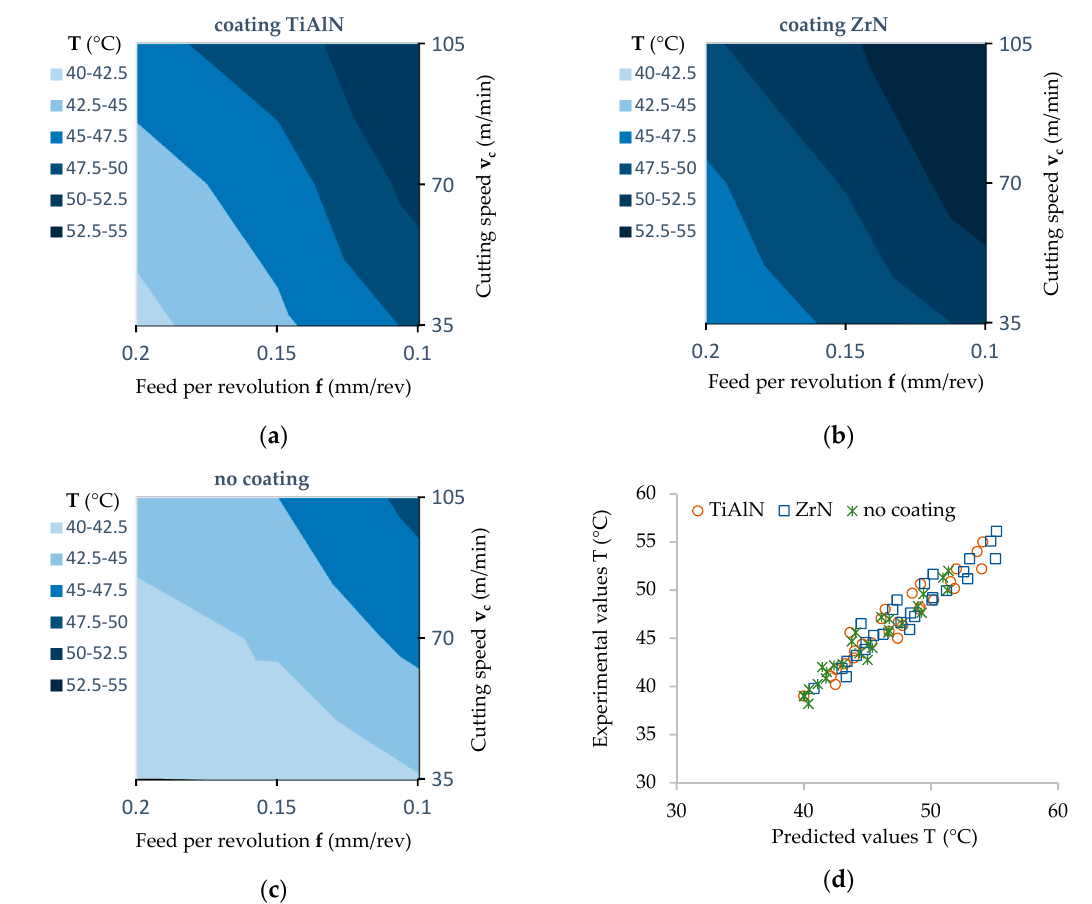
Figure 19. Influence of the feed value on the temperature value (contour diagrams): ( a ) A TiAlN coated drill; ( b ) for a ZrN coated drill; ( c ) for an uncoated drill; ( d ) correlation between the experimental and predicted values of temperature determined for the coated and uncoated